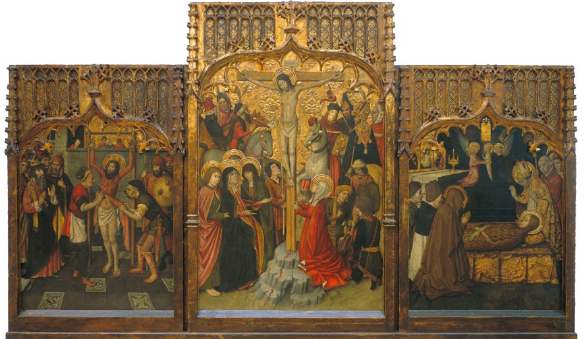
Figure 3. Jaume Huguet, Altarpiece of Martyrdom of Saint Bartholomew; Calvary; Death of Saint Mary Magdalene, 1465–1480, Museu Nacional d’Art de Catalunya (MNAC).